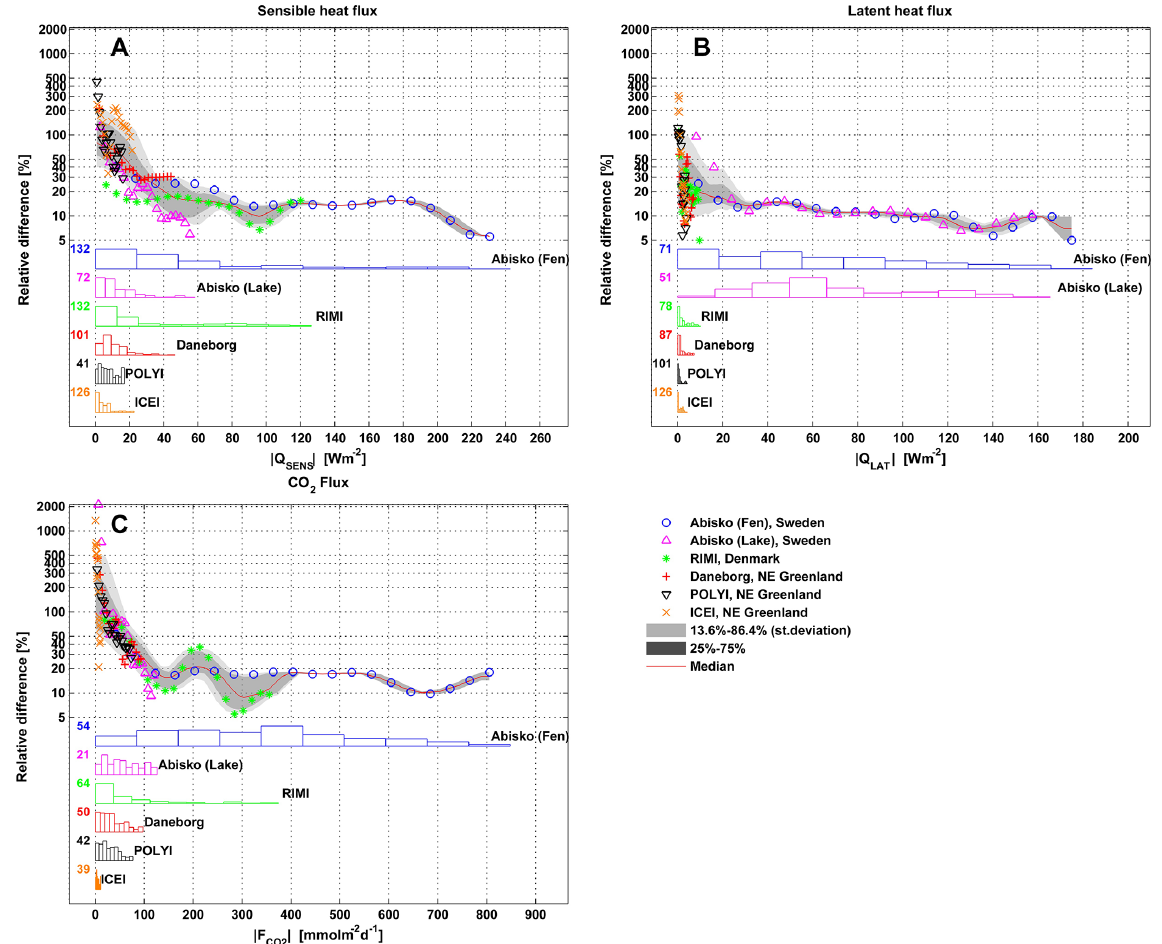
Figure 11. Relative difference in percent (see Eq. 5) is shown logarithmically as a function of absolute flux estimate for all investigated sites. Also shown are the median (red line), standard deviation (light gray area) and 25–75% percentile (dark gray area) of the relative differences. In the bottom of the figure, histograms of absolute ogive optimization flux estimate ranges are shown for each site. Numbers indicated to the left of the histograms are the respective maximum